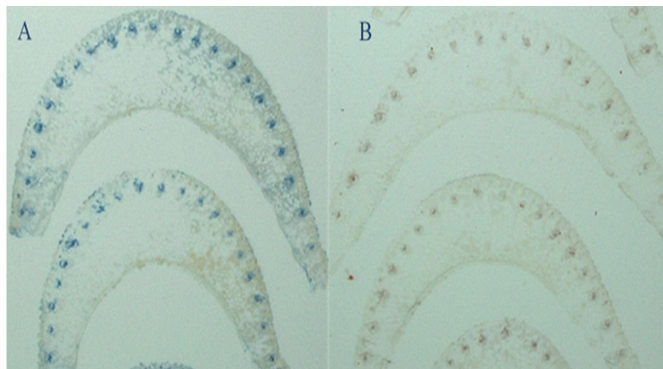
Figure 2. Tissue-blot immunoassay of midrib of top visible dewlap leaves. ( A ) Infected leaves; ( B ) healthy leaves. The blue dots are stained phloem cells where the virus lives.